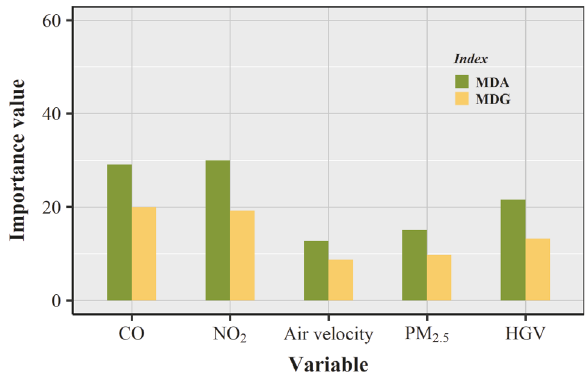
Figure 6: Comparison of importance of different